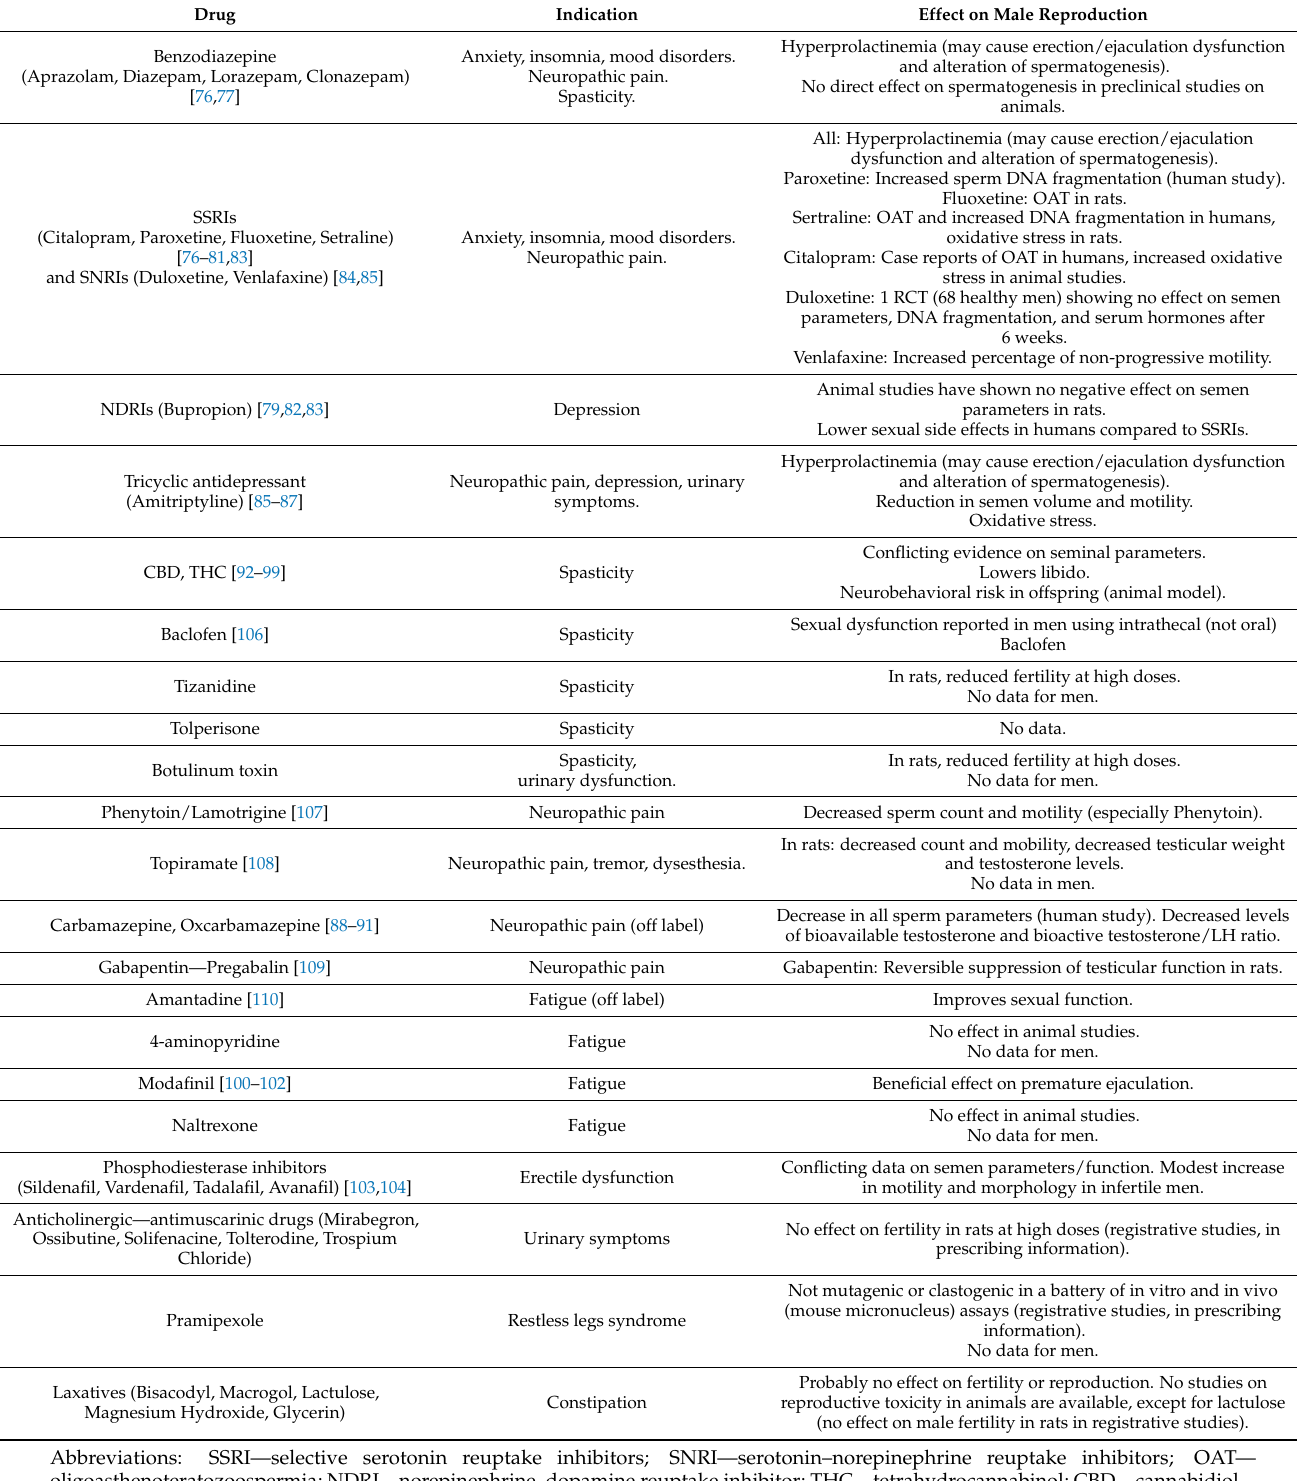
Table 3. Summary of potential gonadotoxicity of symptomatic/supporting therapies for multiple sclerosis in males. Drug Indication Effect on Male Reproduction Anxiety, insomnia, mood disorders. Neuropathic pain. Spasticity. No direct effect on spermatogenesis in preclinical studies on animals.